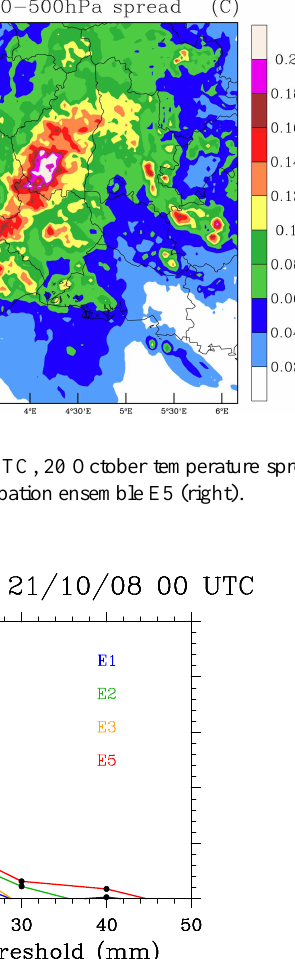
Fig. 13. Area under the ROC curve as a function of the precipitation